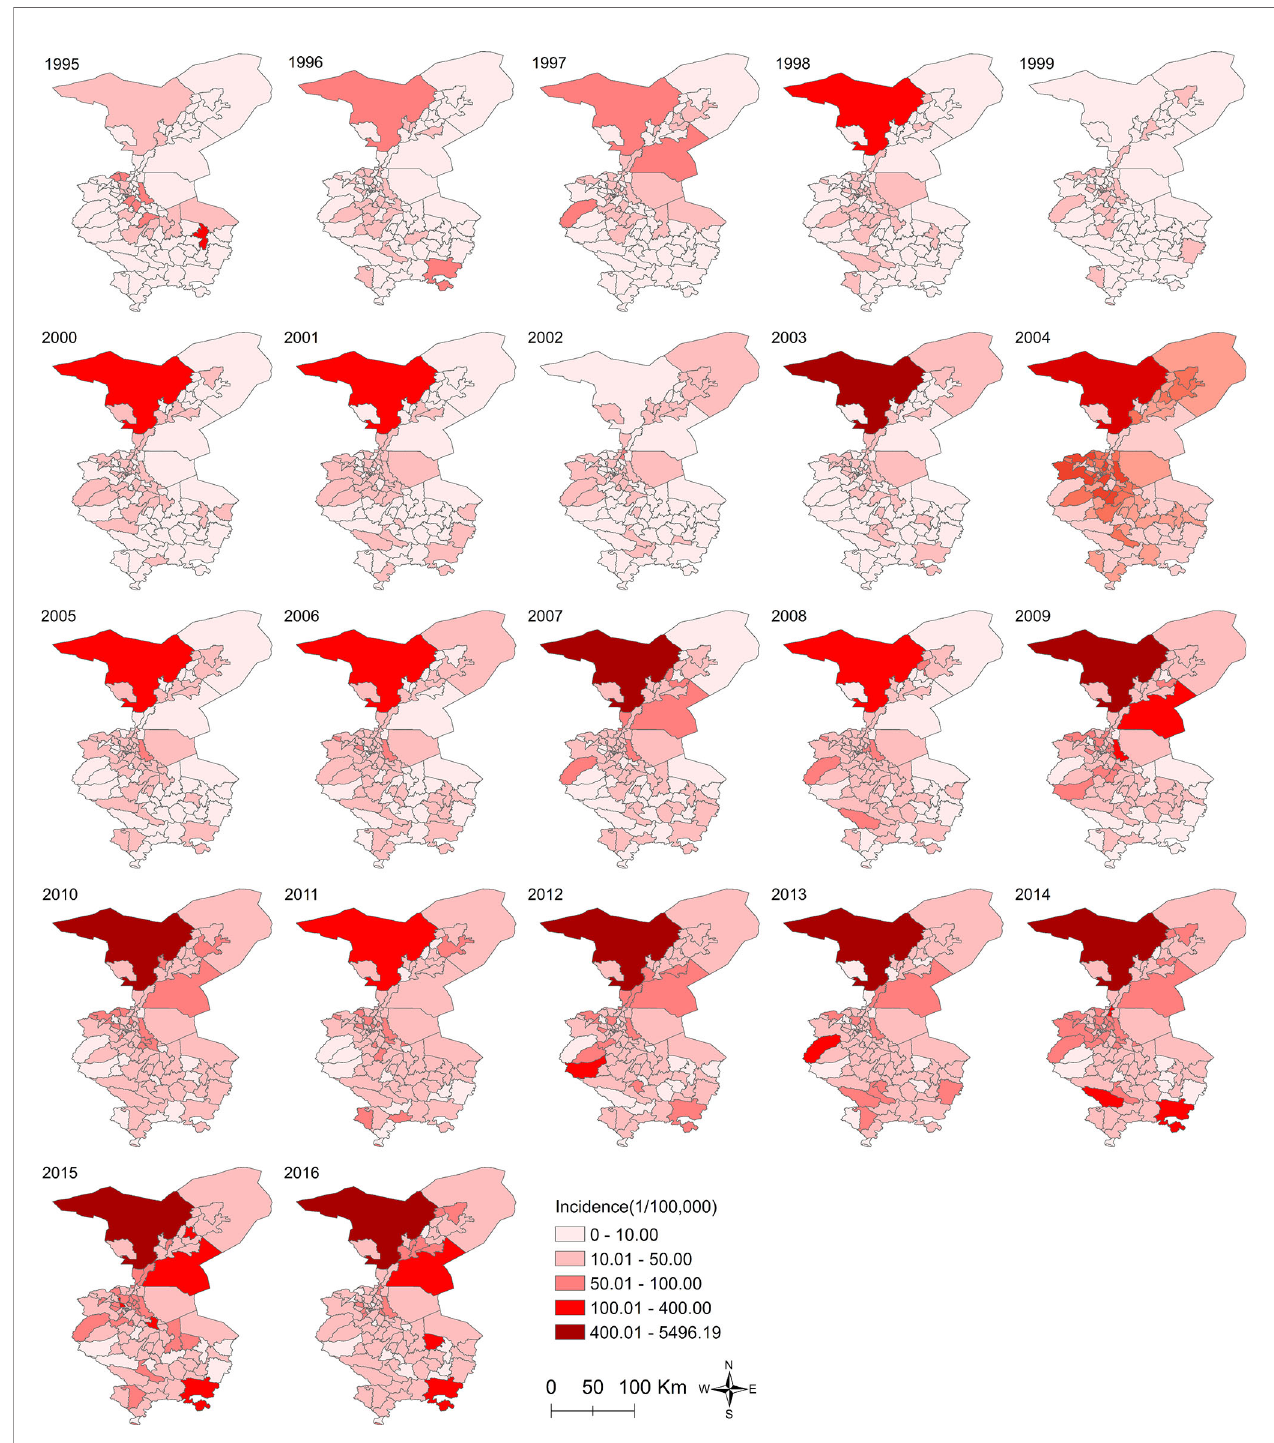
FIGURE 3 | The annual crude incidence rates of all gastrointestinal (GI) cancers among the townships in Wuwei, northwestern China, 1995 –